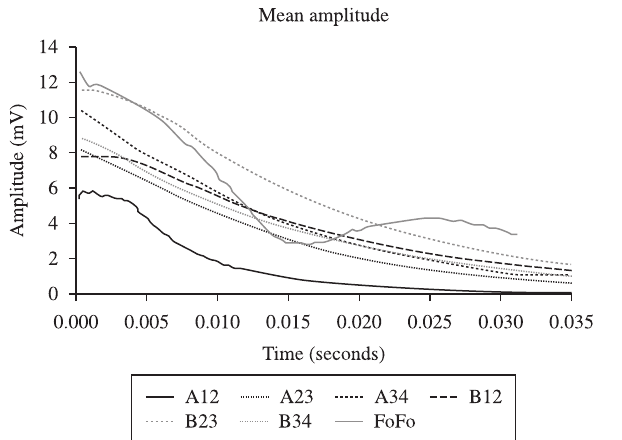
Figure 3. Experimental array for vibrations damping (adapted from Pardini et al. 14 ).